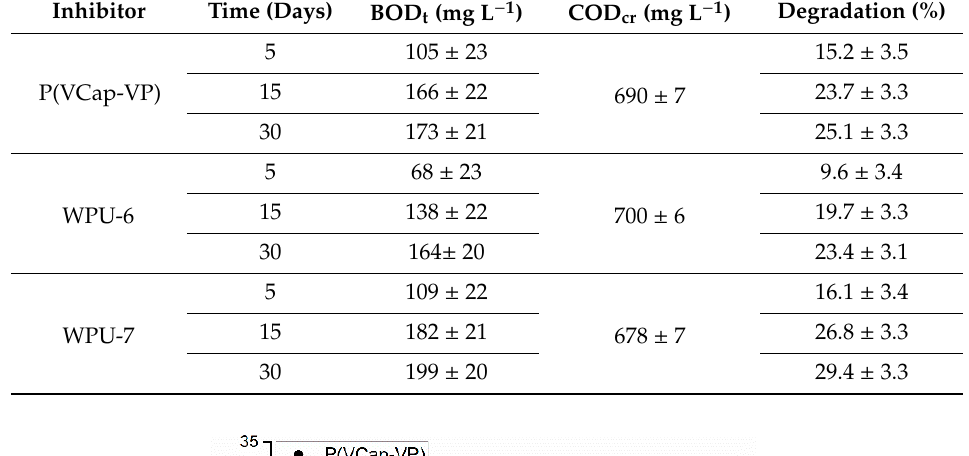
Table 4. Biodegradation of WPU-6, WPU-7, and P(VCap-VP) based on the ratio of biochemical oxygen demand after 5, 15 and 30 days (BOD t ) and chemical oxygen demand (COD cr ).